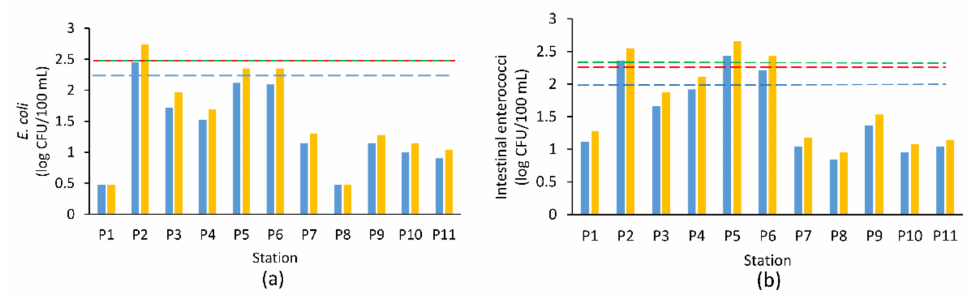
Figure 3. Bathing water quality categories based on the 90th (blue columns) and 95th (orange columns) percentiles of all E. coli ( a ) and intestinal enterococci ( b ) values for both bathing seasons. Dashed lines present water quality thresholds (blue-excellent; green-good; red-sufficient).